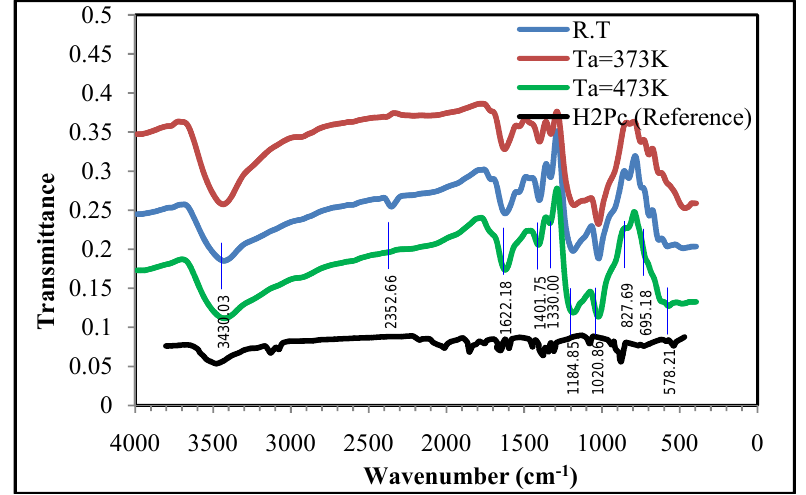
Fig. 9: FTIR spectra for as-deposited and annealed NiPcTc Thin